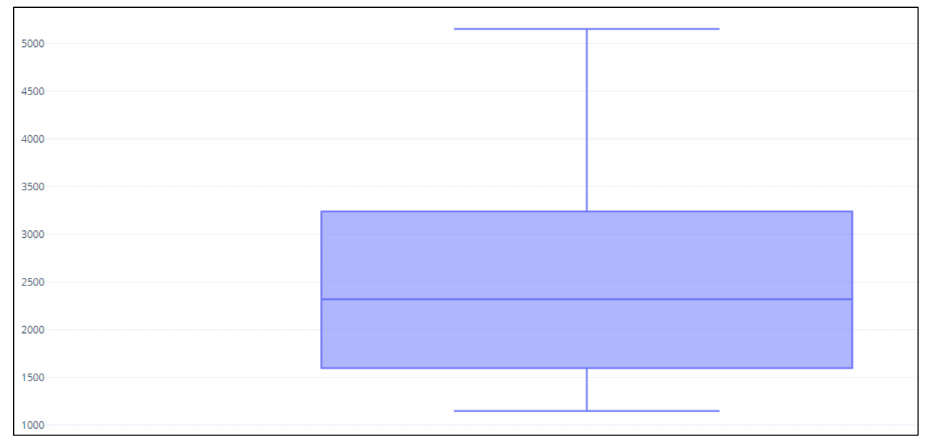
Figure 2. Median next generation sequencing (NGS) read distribution for the entire cohort (1695 cases). Y -axis: number of reads.